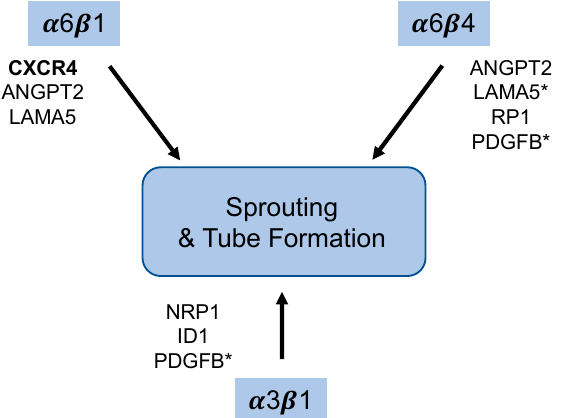
Figure 9. Schematic summary. RNAi-dependent depletion of the α 3 β 1 or the α 6 integrins, α 6 β 1 and α 6 β 4 inhibits endothelial sprouting and tube formation in organotypic co-culture models. The expression of CXCR4 shown in bold was inhibited only by the depletion of the integrin α 6 subunit, and not by depletion of either the β 4 or α 3 subunit, suggesting that α 6 β 1 is the only laminin-binding integrin that impacts CXCR4 expression (Figures 4 and 7 and [7]). Depletion of either the α 6 or β 4 subunit inhibited migration, as well as the expression of ANGPT2 and LAMA5 mRNA; this suggests that α 6 β 4 regulates the expression of these genes, but does not exclude the possibility of a contribution from α 6 β 1. The depletion of α 3 β 1 or α 6 β 4 inhibited the expression of NRP1 and PDGFB, whereas the expression of ID1 was only inhibited by the depletion of α 3 β 1. * Indicate genes whose expression was significantly inhibited by two of the three siRNA-targeting sequences.